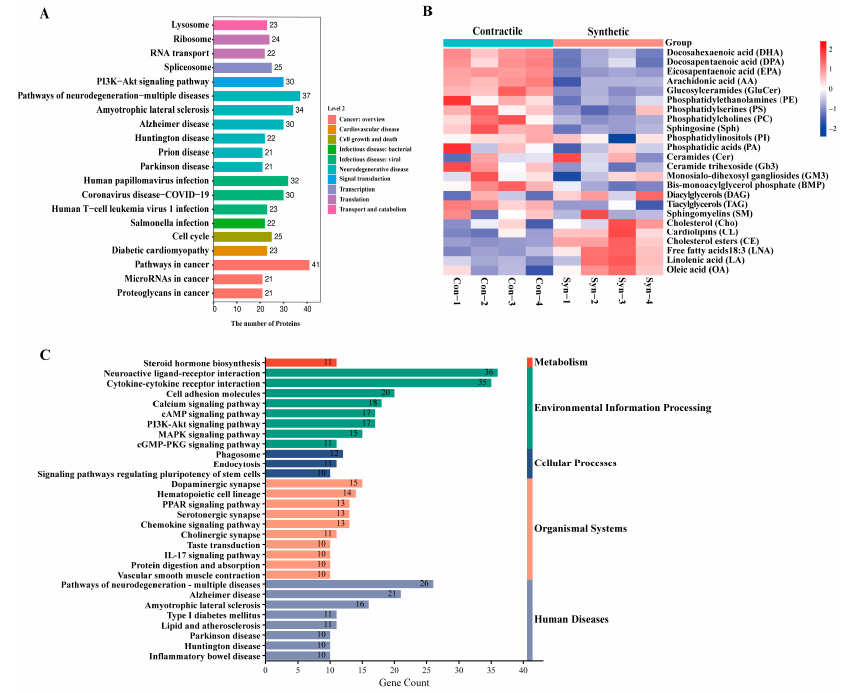
Figure 1. Multi-omics points to a possible link between VSMC phenotypic switching and neurodegenerative diseases. ( A ) KEGG pathway enrichment of differentially expressed proteins between contractile and synthetic VSMCs in mice from proteomic analyses ( n = 3 independent samples). ( B ) Heatmap of each lipid class between contractile and synthetic VSMCs in mice from lipidomic analyses ( n = 4 independent samples). ( C ) KEGG pathway enrichment of upregulated differentially expressed mRNAs in the arteries of Sm22 α − / − mice compared with WT mice from transcriptomic analyses ( n = 8 mice per